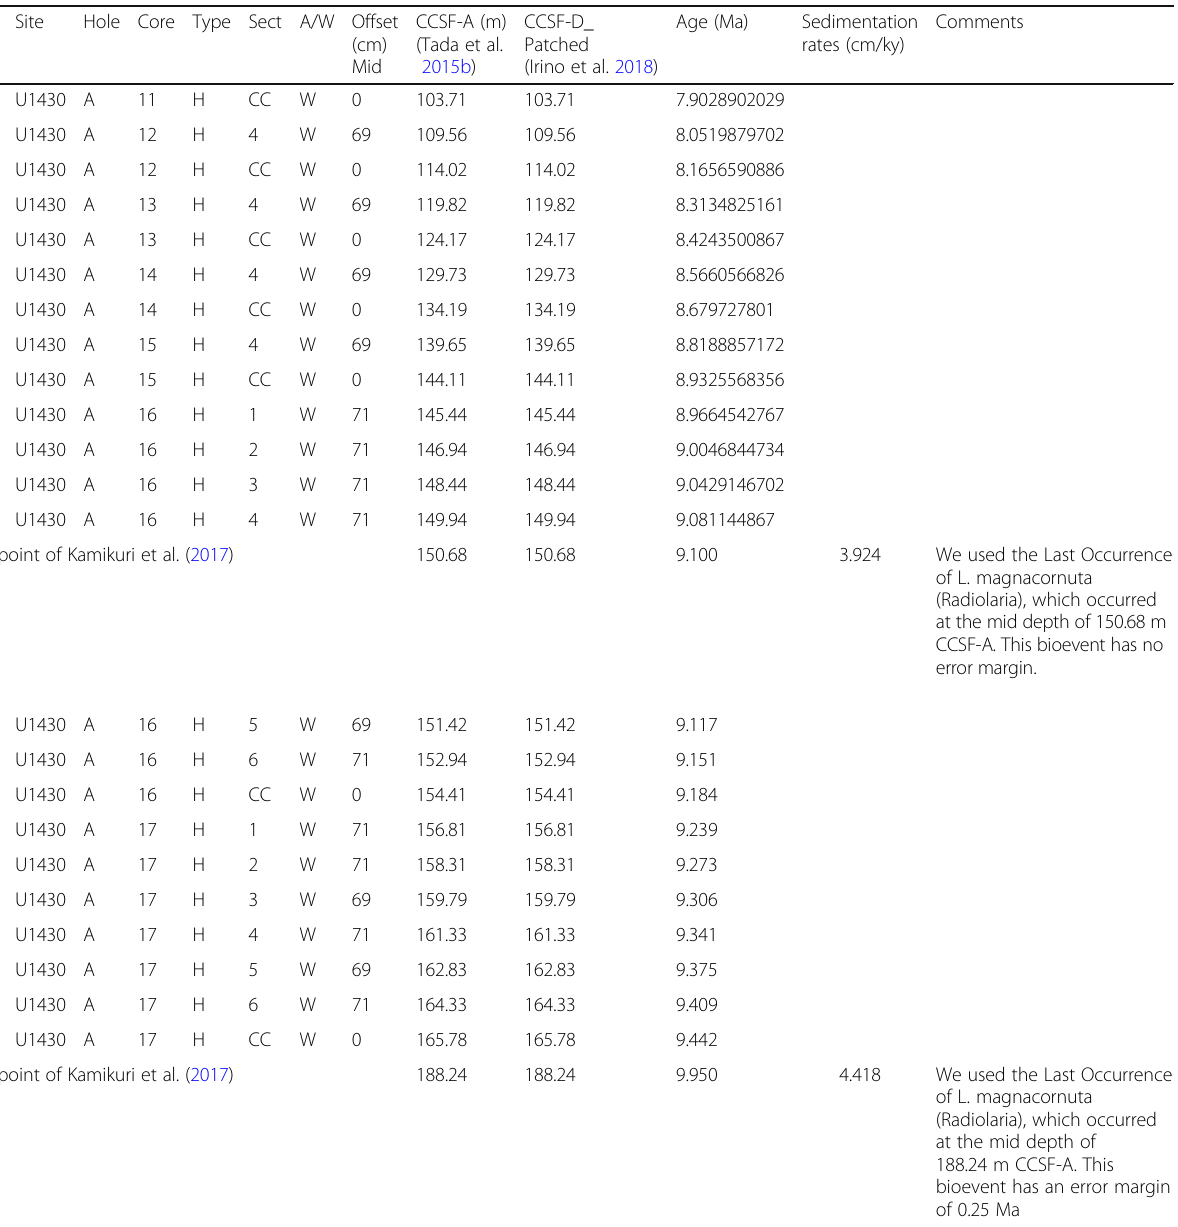
Table 2 Samples used, biostratigraphic tie points, and related sedimentation rates at IODP Site U1430 (cm/ky) (Continued) Exp